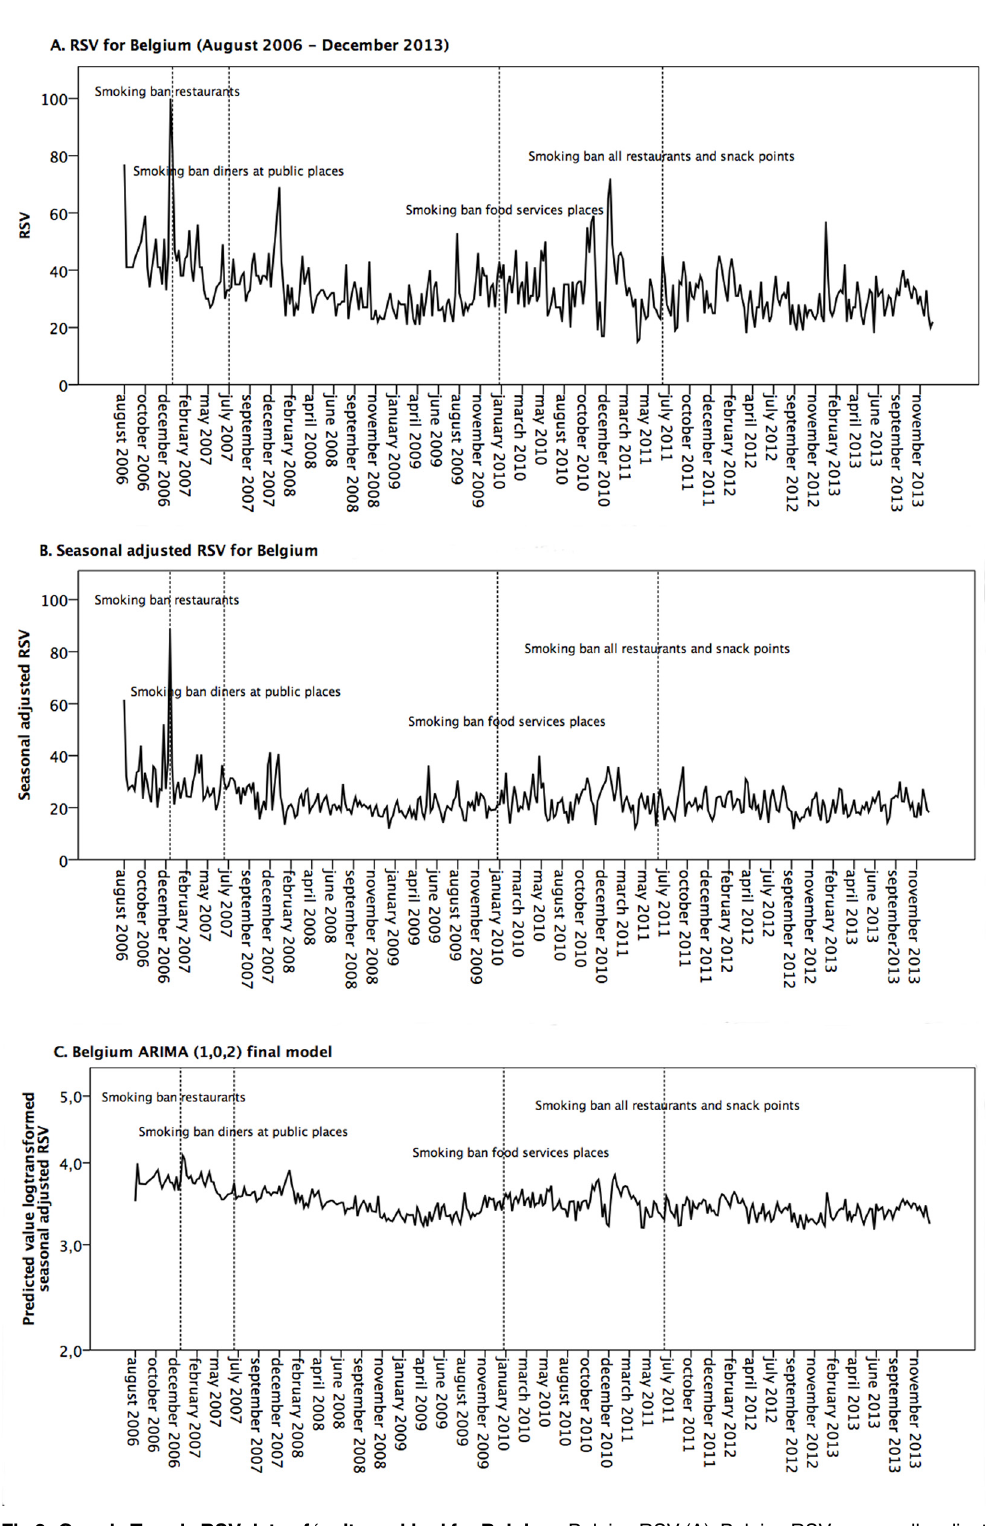
Fig 2. Google Trends RSV data of ‘ quit smoking ’ for Belgium. Belgian RSV (A), Belgian RSV seasonally adjusted (B) and as ARIMA (1,0,2) Model